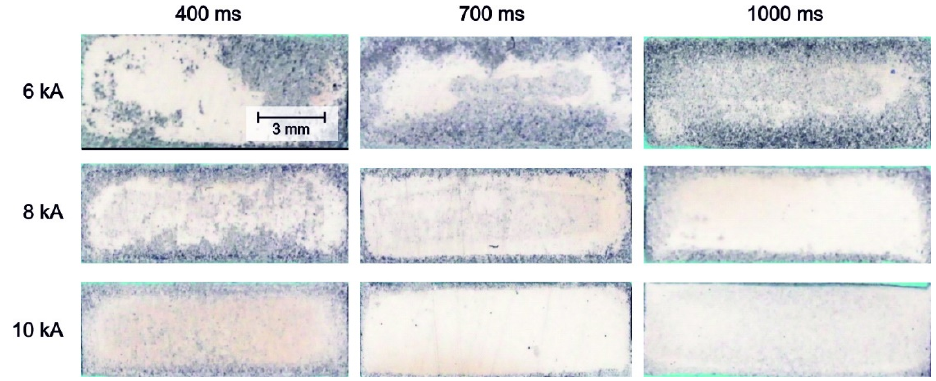
Figure 10. Porosity distribution in MF ‐ ERS Fe compacts. White areas (more reflecting) indicate a lower porosity content.